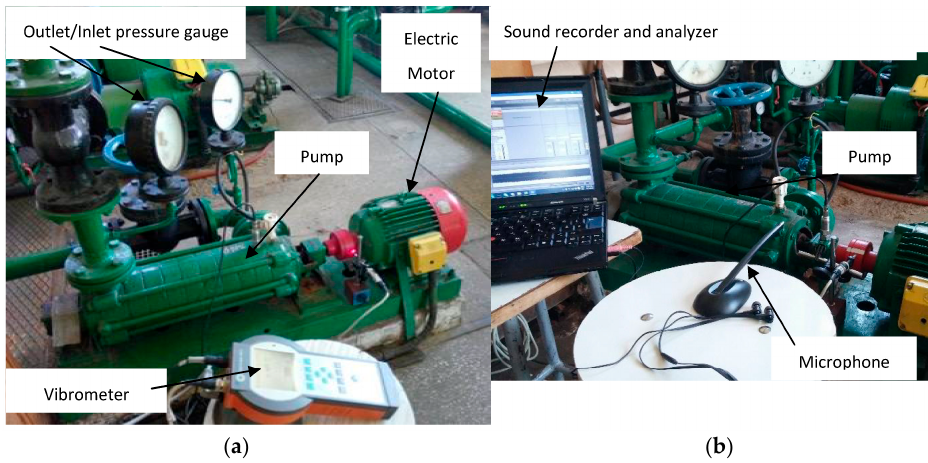
Figure 2. Stand images: ( a ) speed transducer and vibration velocity transducer; ( b ) sound level meter and acquisition system.